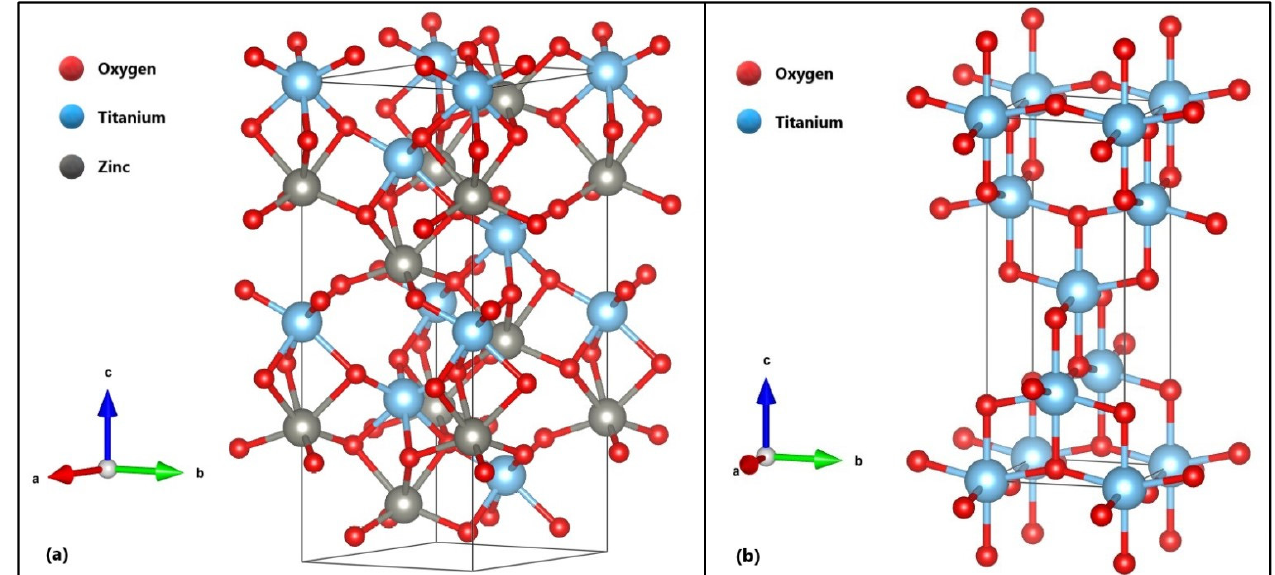
Figure 1. Optimized structures of ( a ) ZnTiO 3 and ( b ) TiO 2.